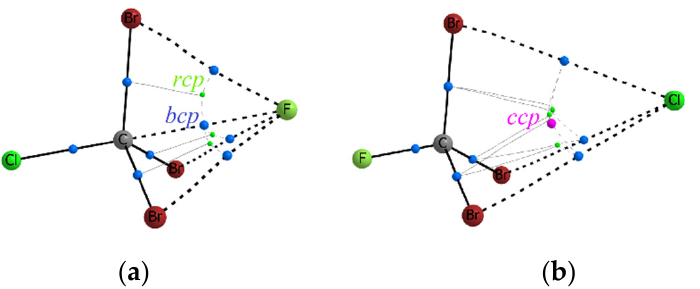
Figure 1. Different curvature of electron density and signature of cp in isoelectronic complexes ( a ) Cl–CCl 3 …F − and ( b ) F–CCl 3 …Cl – .